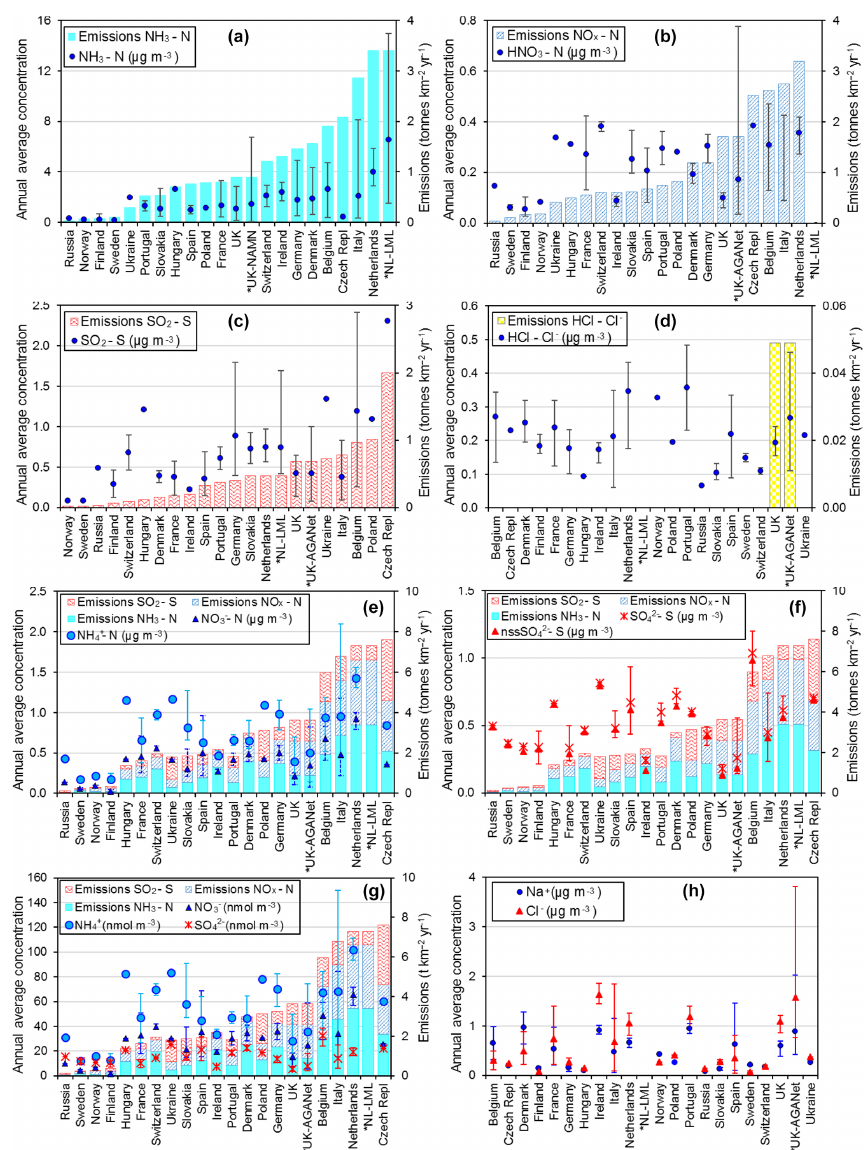
Figure 9. Comparisons of annual averaged gas and aerosol concentrations (2007–2010) of sites in the NEU DELTA ® network, grouped by country, with the respective 4-year-averaged annual emission densities of gases (NH 3 , NO x , and SO 2 ) over the same period. Monitoring data from three national monitoring networks: ∗ UK NAMN (NH 3 from 72 sites and NH + from 30 sites; Tang et al., 2018a), ∗ UK AGANet 4 (raw uncorrected HNO 3 , SO 2 , HCl, NO − , SO 2 − , Cl − , Na + from 30 sites; Tang et al., 2018b), and ∗ NL-LML (NH 3 and SO 2 from 8 sites; 3 4 van Zanten et al., 2017) are also included to illustrate the wider range of concentrations from larger numbers of sites. Error bars show the minimum and maximum concentrations measured in each country in the network. Where error bars are not visible, this indicates that either the country has measurement from just one site, or the range of concentrations measured are very close to the